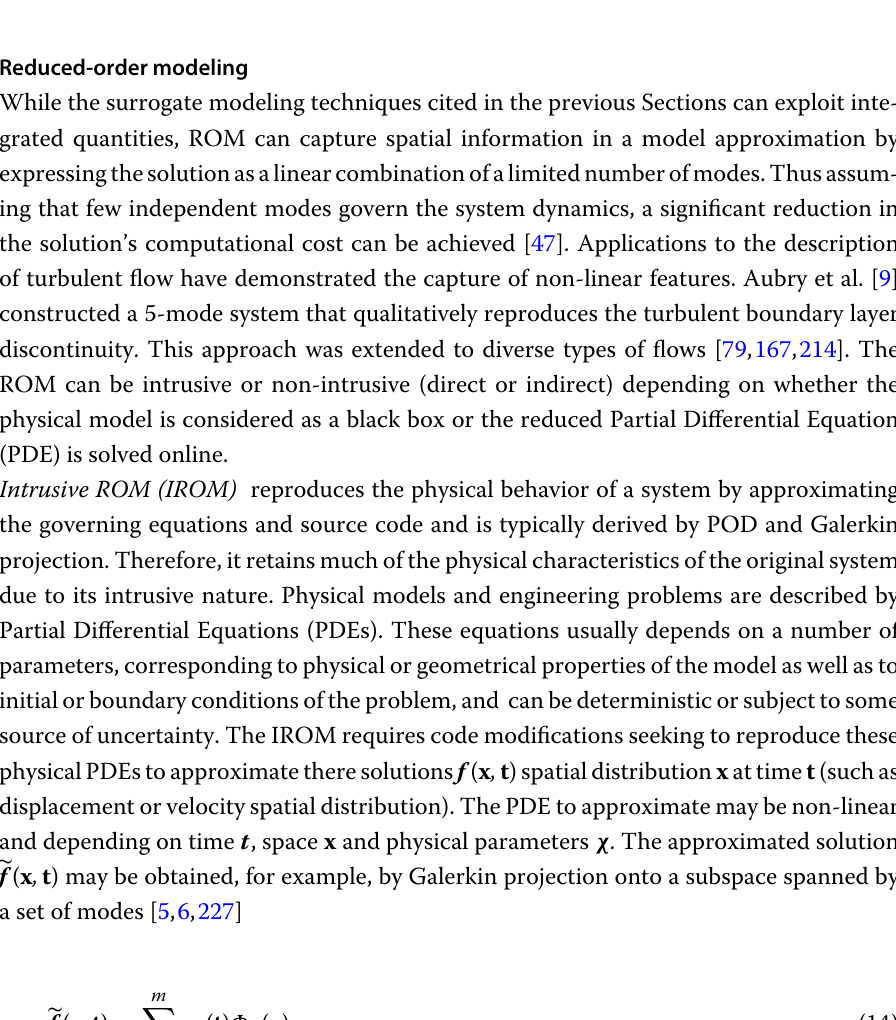
Fig. 5 The full-field SBO